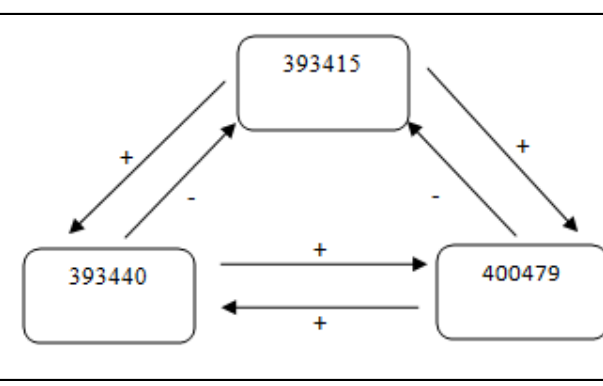
Fig. 7. Relationship between the products